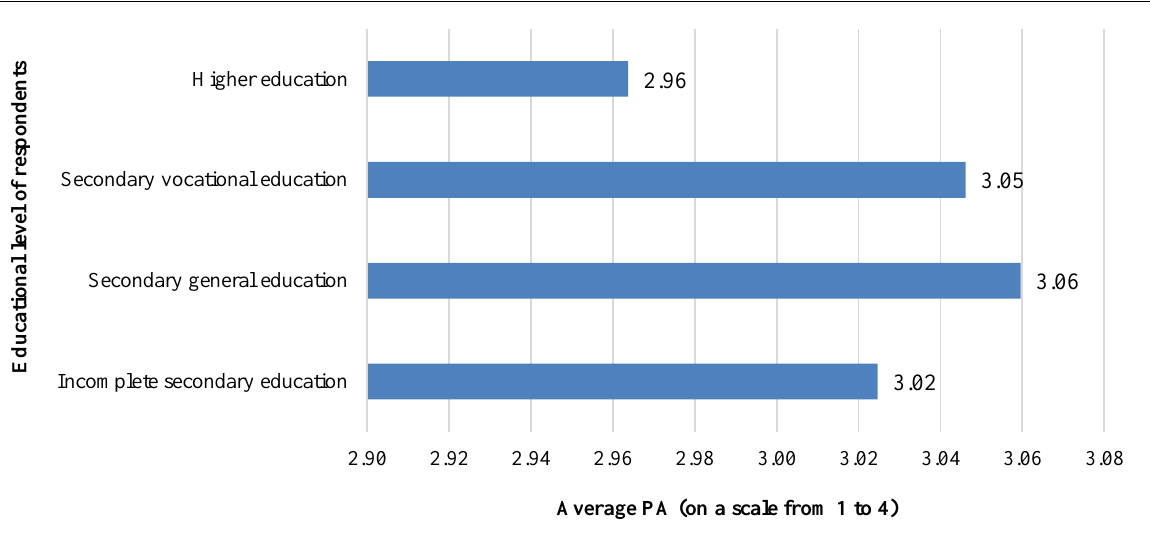
Figure 9. Relationship between respondent's educational level and